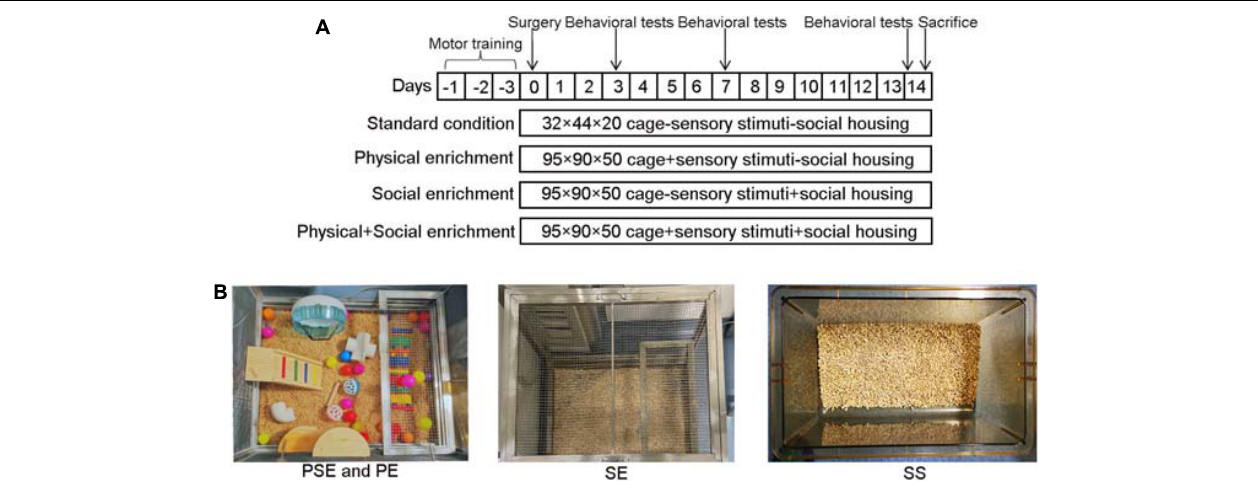
FIGURE 1 | Flow chart of the experimental protocol and enrichment settings. (A) The experimental protocol and group settings. (B) The setting of PSE, PE, SE, and